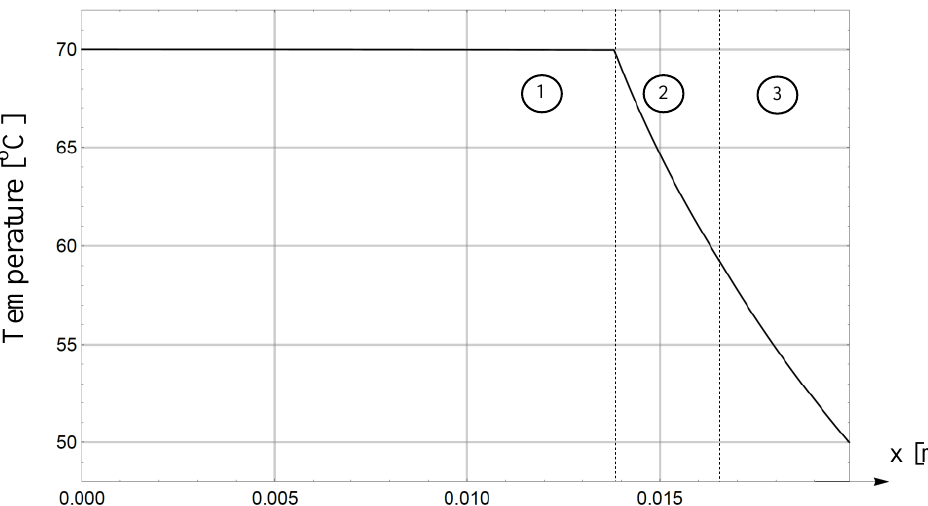
Figure 2. Temperature change in the elliptical conductor on semi-axis y = 0 (for I cr = 553.51 A ).